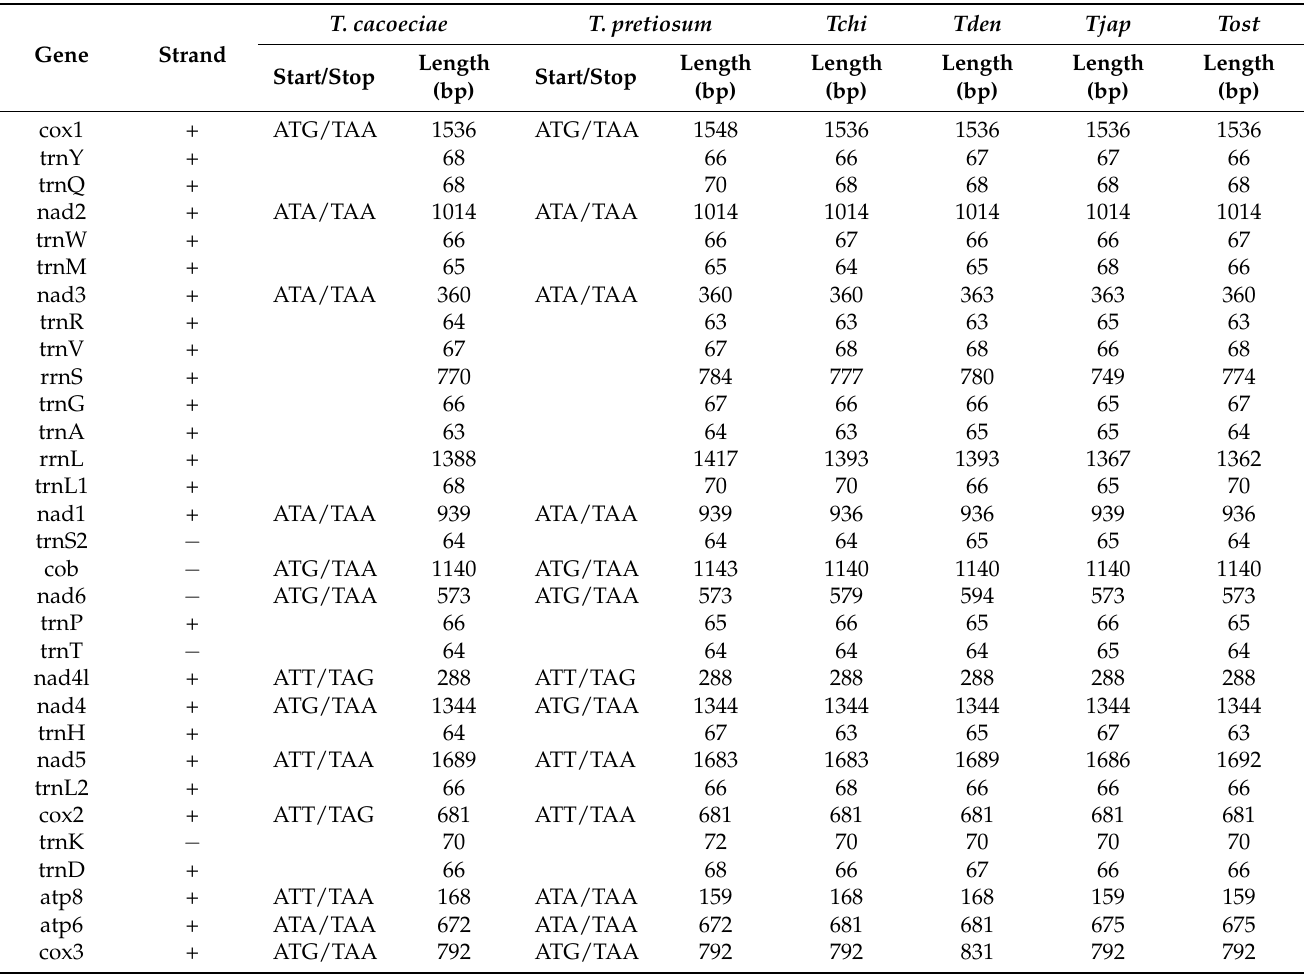
Table 1. Summary of mitochondrial genes in Trichogramma cacoeciae and T. pretiosum